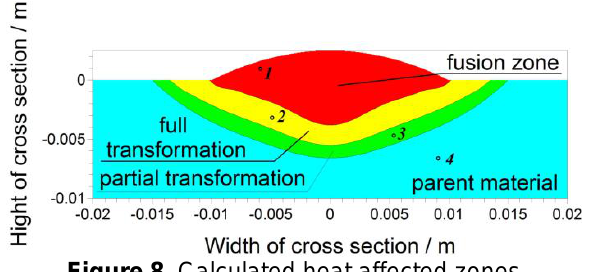
Figure 8. Calculated heat affected zones